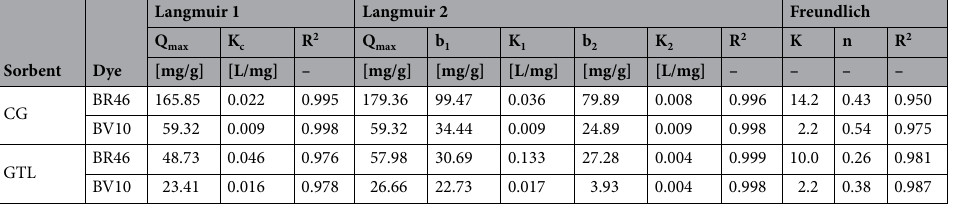
Table 4. Constants determined from the Langmuir 1 model, Langmuir 2 model, and Freundlich model.